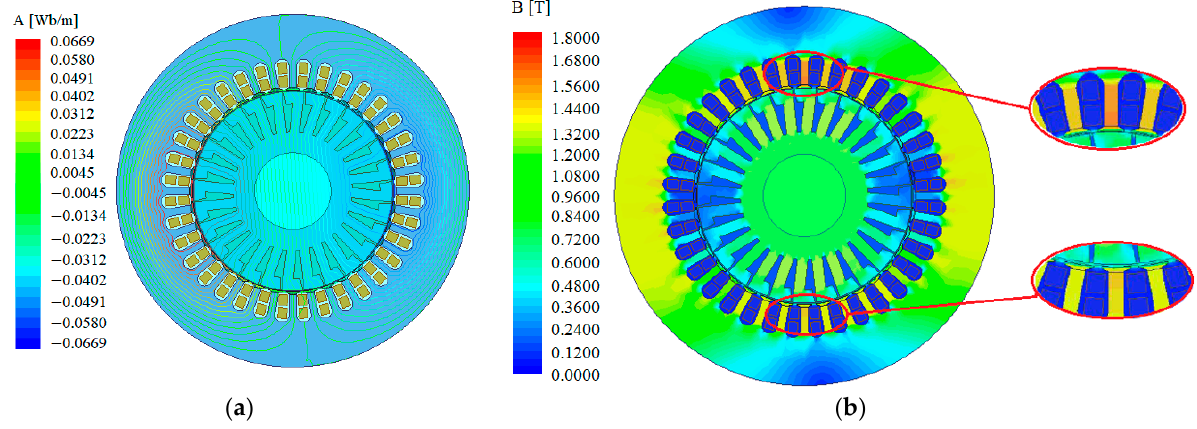
Figure 10. The magnetic lines distribution and the magnetic density diagram of the motor under dynamic eccentric conditions: ( a ) magnetic lines distribution; ( b ) magnetic density diagram.